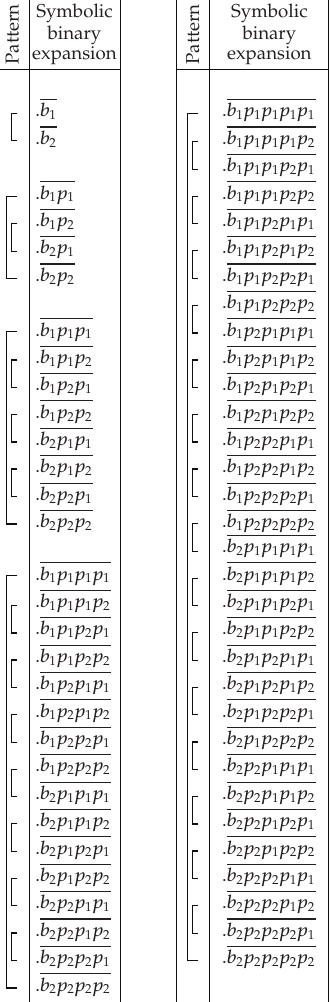
Figure 8: Coupling pattern of the external arguments of the BMSs up to fourth level in a canonical double- spiral